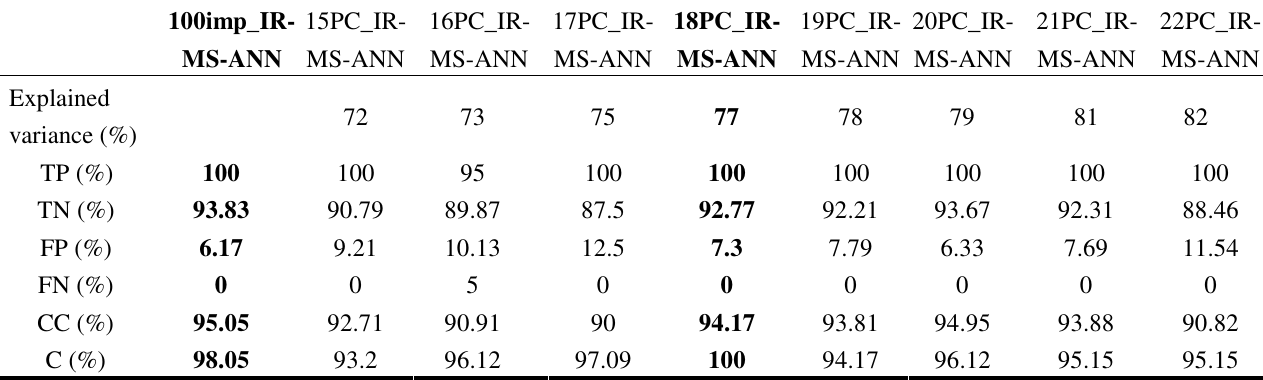
Table 1. Validation results and explained variance for the 100imp_IR-MS-ANN and the PC-ANN networks.